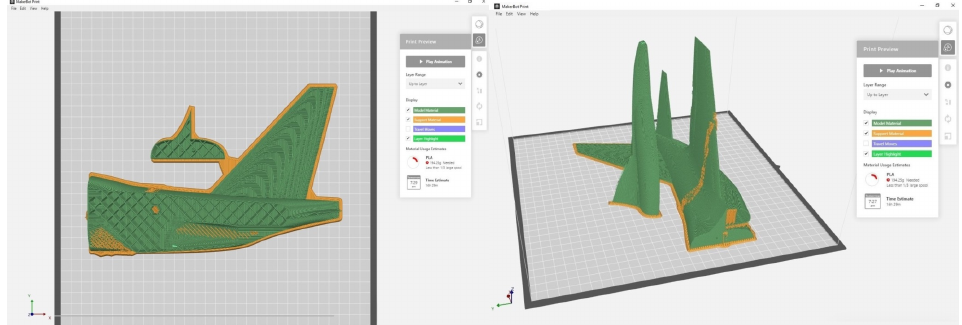
Figure 7. Preview of printout of M-346 model divided into two parts with visible fixing holes and breakdown into layers in MakerBot Print software.